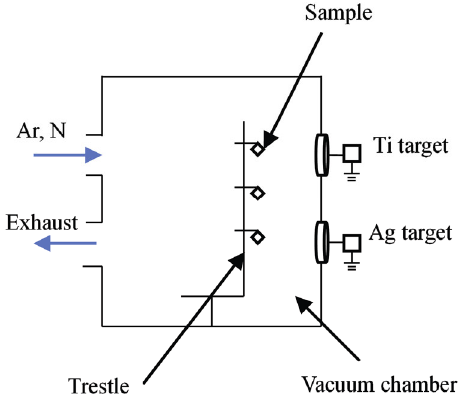
Fig. 1 Sketch of the vacuum